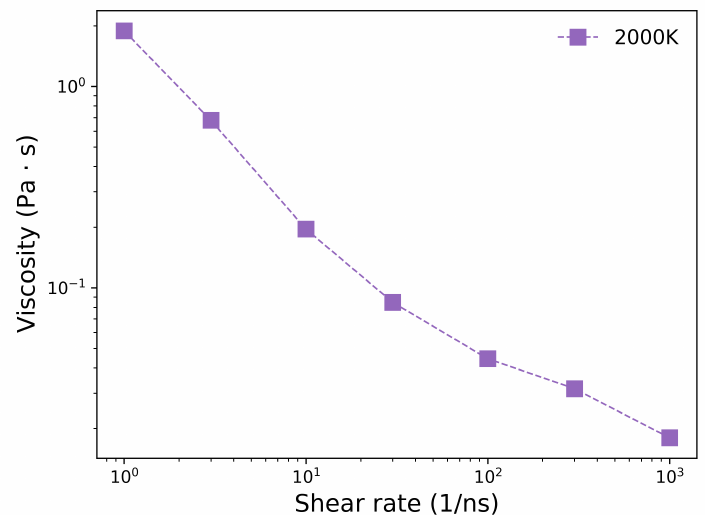
Figure 10. Simulated shear viscosity with NEMD as a function of shear rate for Na 2 O–CaO–Al 2 O 3 – SiO 2